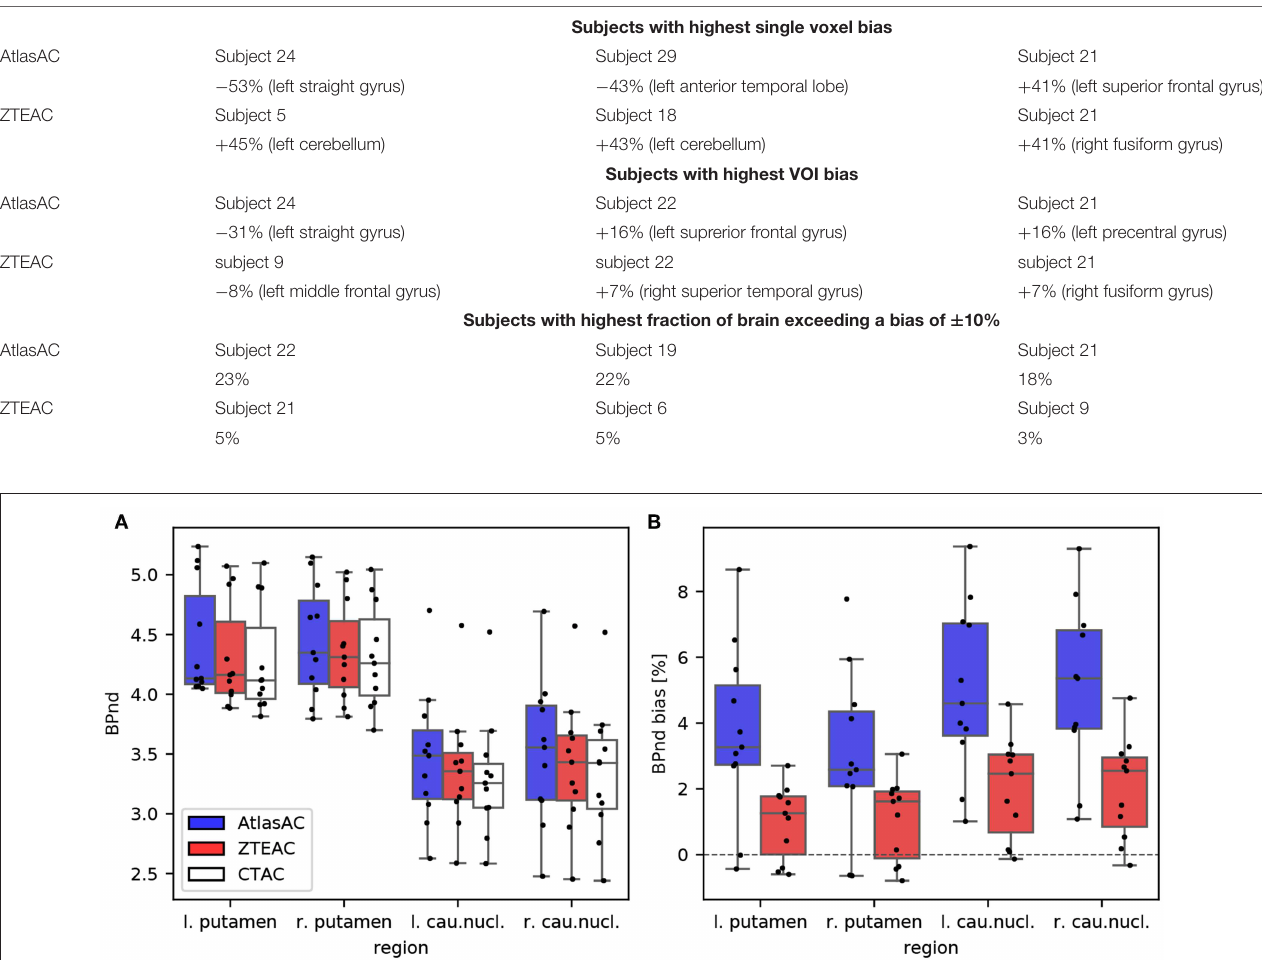
TABLE 1 | Results of outlier analysis of the static acquisitions in terms of subjects with highest voxel bias, highest VOI bias, and highest fraction of brain exceeding a bias of ± 10%.